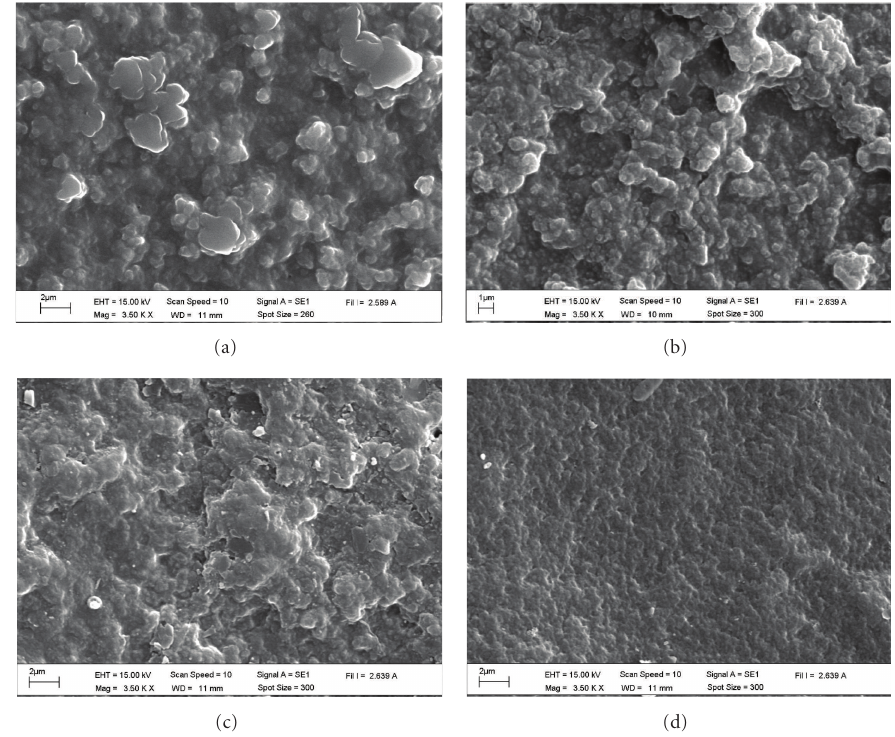
Figure 1: Surface morphology of CS/SF blend films with various blend ratios of chitosan :fibroin (CF) of (a) 3:1, (b) 2 :1 (c) 1 :1, and (d) 1:2 which was observed by SEM at 3500x magnification.